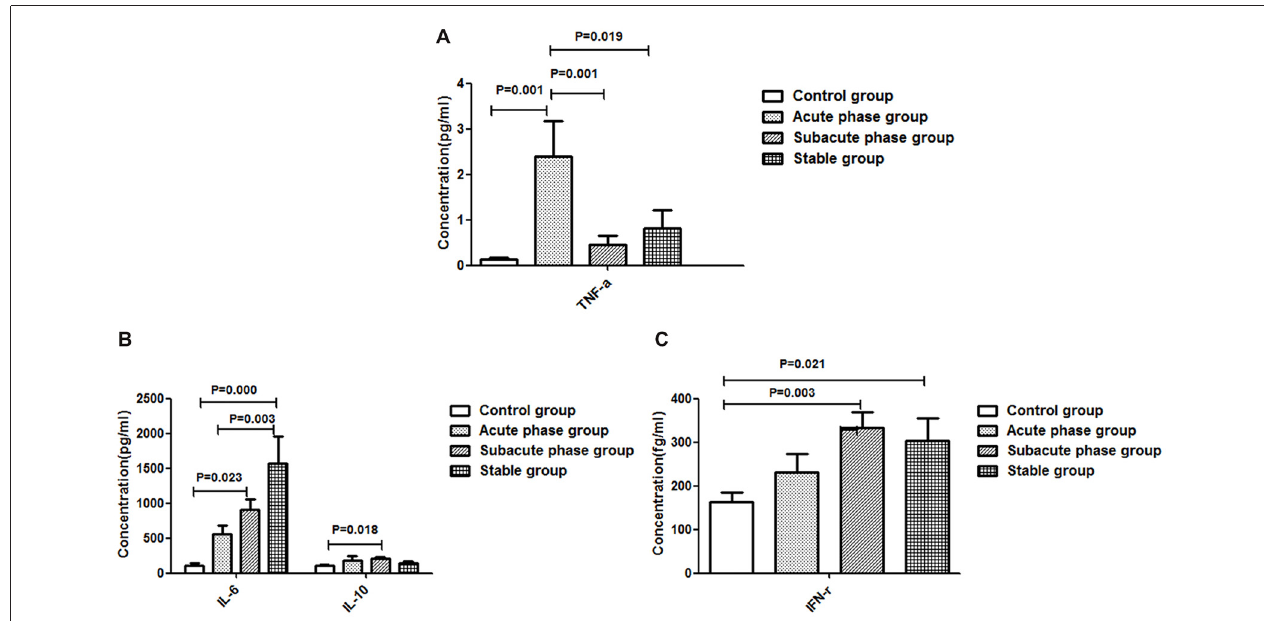
FIGURE 4 | Concentration of cytokines in ischemic stroke groups and the control group. (A) Concentration of TNF- α in ischemic stroke groups and the control group. (B) Concentration of IL-6 and IL-10 in ischemic stroke groups and the control group. (C) Concentration of IFN- γ in ischemic stroke groups and the control group (comparisons between groups were performed via one-way ANOVA, and a post hoc test was used to determine differences between groups. Graphs show the mean + SEM; Control group ( n = 14), Acute phase group ( n = 18), Sub-acute phase group ( n = 31), Stable phase group ( n =